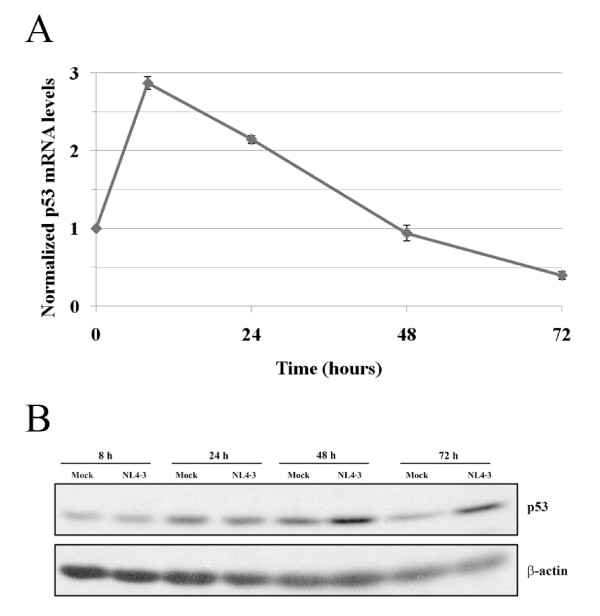
Quantification of p53 by qRT-PCR and western blot. (A) The purified cell population highly enriched in CD4+ T lymphocytes was either left uninfected or infected with NL4-3 wt for 8, 24, 48 and 72 h. Total RNA from the five original healthy donors and from six additional donors was isolated. Ribosomal 18S and p53 RNA levels were quantified by qRT-PCR. Data shown is representative of all studied samples (i.e. a total of eleven) normalized on ribosomal 18S. (B) Cells were either left uninfected (mock) or infected with NL4-3 wt for the indicated time periods. Next, p53 and actin protein levels were estimated by western blot analysis using a specific antibody.